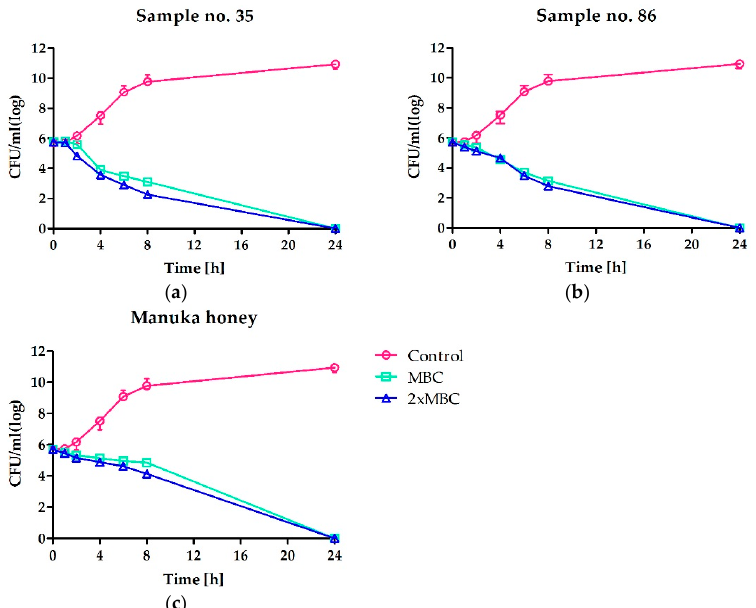
Figure 1. Time-kill curves of S. aureus ATCC 25923 cultivated in absence or presence of two the most active honeys: ( a ) multi-floral honey and ( b ) buckwheat honey, both collected by professional beekeepers; in comparison to manuka honey ( c ). Concentrations of honeys are presented in relation to MBC determined.